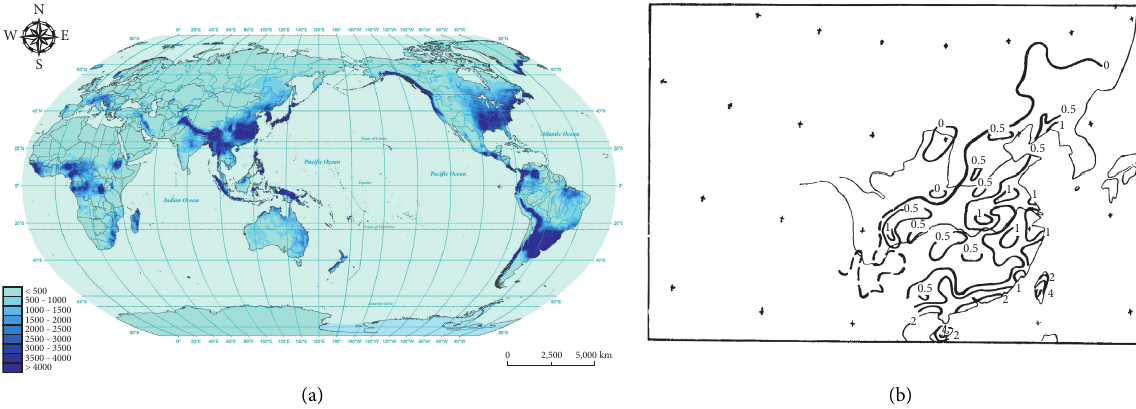
Figure 3: The spatial distribution of heavy rainfall. (a) The global average annual heavy rainfall over land from 1991 to 2000 (units: mm · 10a − 1 ) [27]. (b) Average number of days with heavy rain in eastern China (daily rainfall ≥ 100mm) [28].